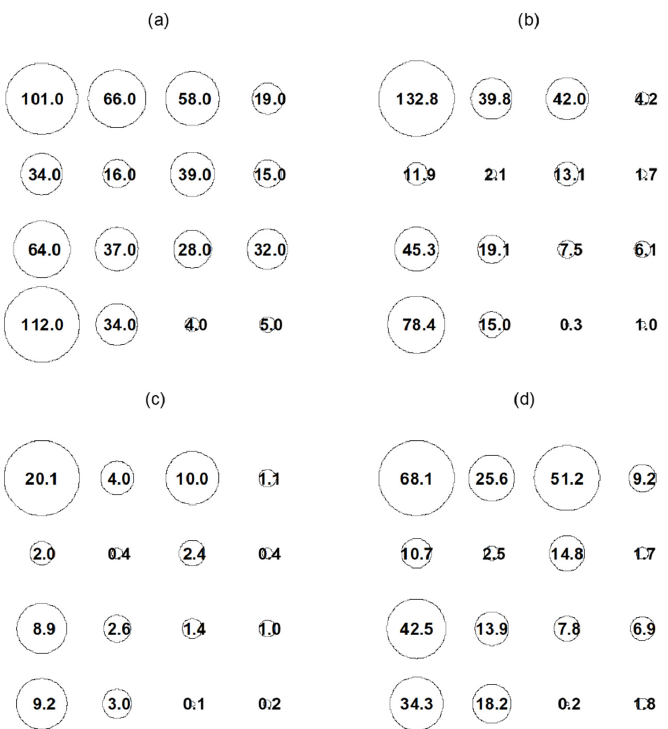
Figure 10. Quantitative determination of the indicators of dry and wet nodes. The distribution of node value sizes shows a strong regularity. The value in the upper left corner is generally the largest, and the value in the lower right corner is generally the smallest, with a decreasing trend from the upper left corner to the lower right corner. ( a ) Number of rainy days (days), ( b ) total annual precip- itation (mm), ( c ) daily average precipitation (mm/day), ( d ) 95th percentile precipitation value (mm).